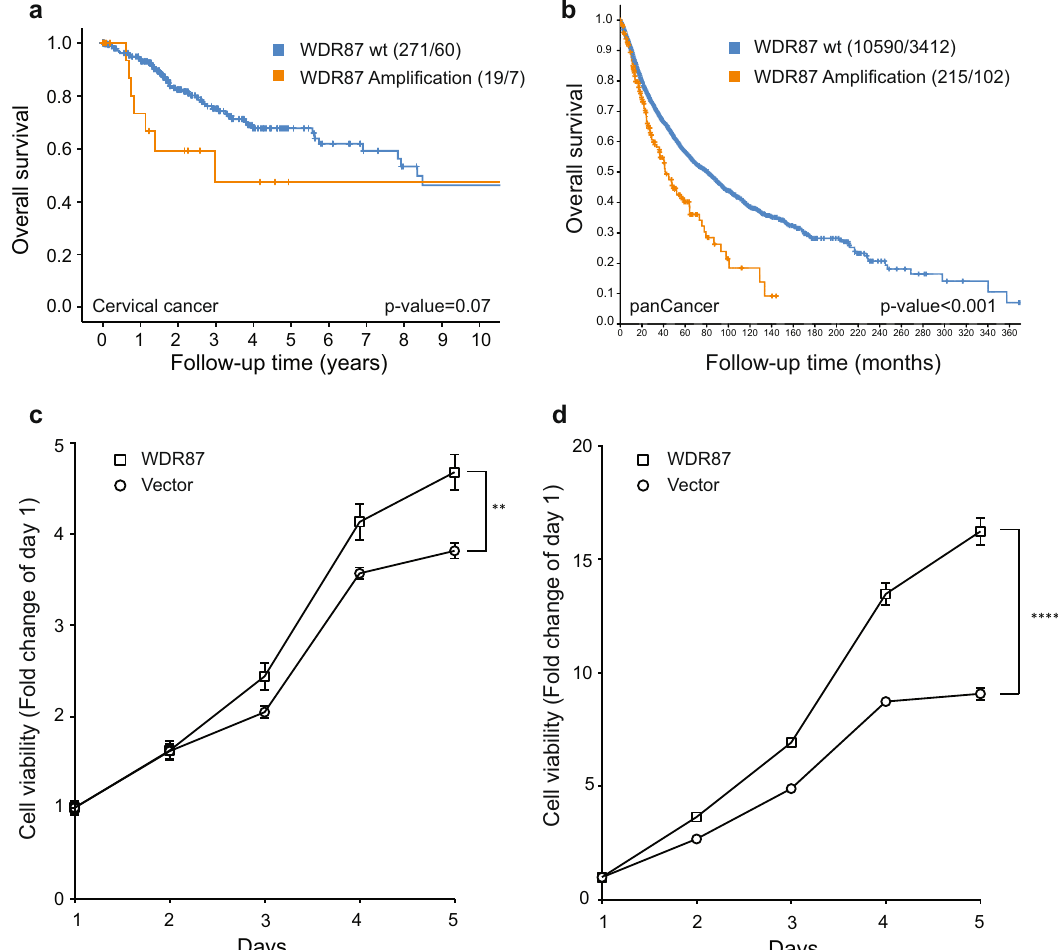
Fig. 6 WDR87 ampli fi cation in relation to survival and tumor cell growth. Overall survival in The Cancer Genome Atlas (TCGA) cervical cancer patients ( n = 290) ( a ) and within the cBioPortal PanCancer Atlas Dataset ( b ) in relation to WDR87 gene ampli fi cation status represented by a Kaplan – Meier curve with probability values for Mantel – Cox log-rank test that compares categories. The number of patients and events are given in parentheses (patients/events). Cellular proliferation assay in the cervical cancer cell line CRL1595 ( c ) and the kidney-derived HA1E cell line ( d ) comparing WDR87 overexpression versus WDR87 normal expression. The error bars represent standard outputs between these two groups revealed 14 ampli fi cation events including CD274 , EGFR , and KRAS and 32 deletion events were unique to the Tp*C tumors, whereas six ampli fi cation events and 16 deletion events were unique to the *CpG tumors. Our fi ndings suggest that the mutational processes associated with different signatures may elevate the importance of some copy number alterations for cervical carcinogenesis, while perhaps making others redundant. We detected a broad range of mutations and homozygous deletions in DDR genes. DNA damage and mutagenesis are enabling hallmarks of genomic instability in cancer 26 . Patients with advanced cervical cancer typically receive radiotherapy in combination with platin-based chemotherapy. These platinum- based agents generate inter- and intra-strand DNA crosslinks, which affect DNA unwinding and subsequently blocking DNA replication, leading to cytotoxicity predominantly in the S-phase. In this process, single-stranded DNA becomes exposed and recruits ATRIP, which further triggers the ATR signaling axis to stabilize and restart replication. In addition, ATR regulates cell cycle progression by activating Chk1 (gene name: CHEK1 ), which in turn activates p53. ATR is also involved in double-strand DNA breaks by activating BRCA1, among others. ATM plays a key role in